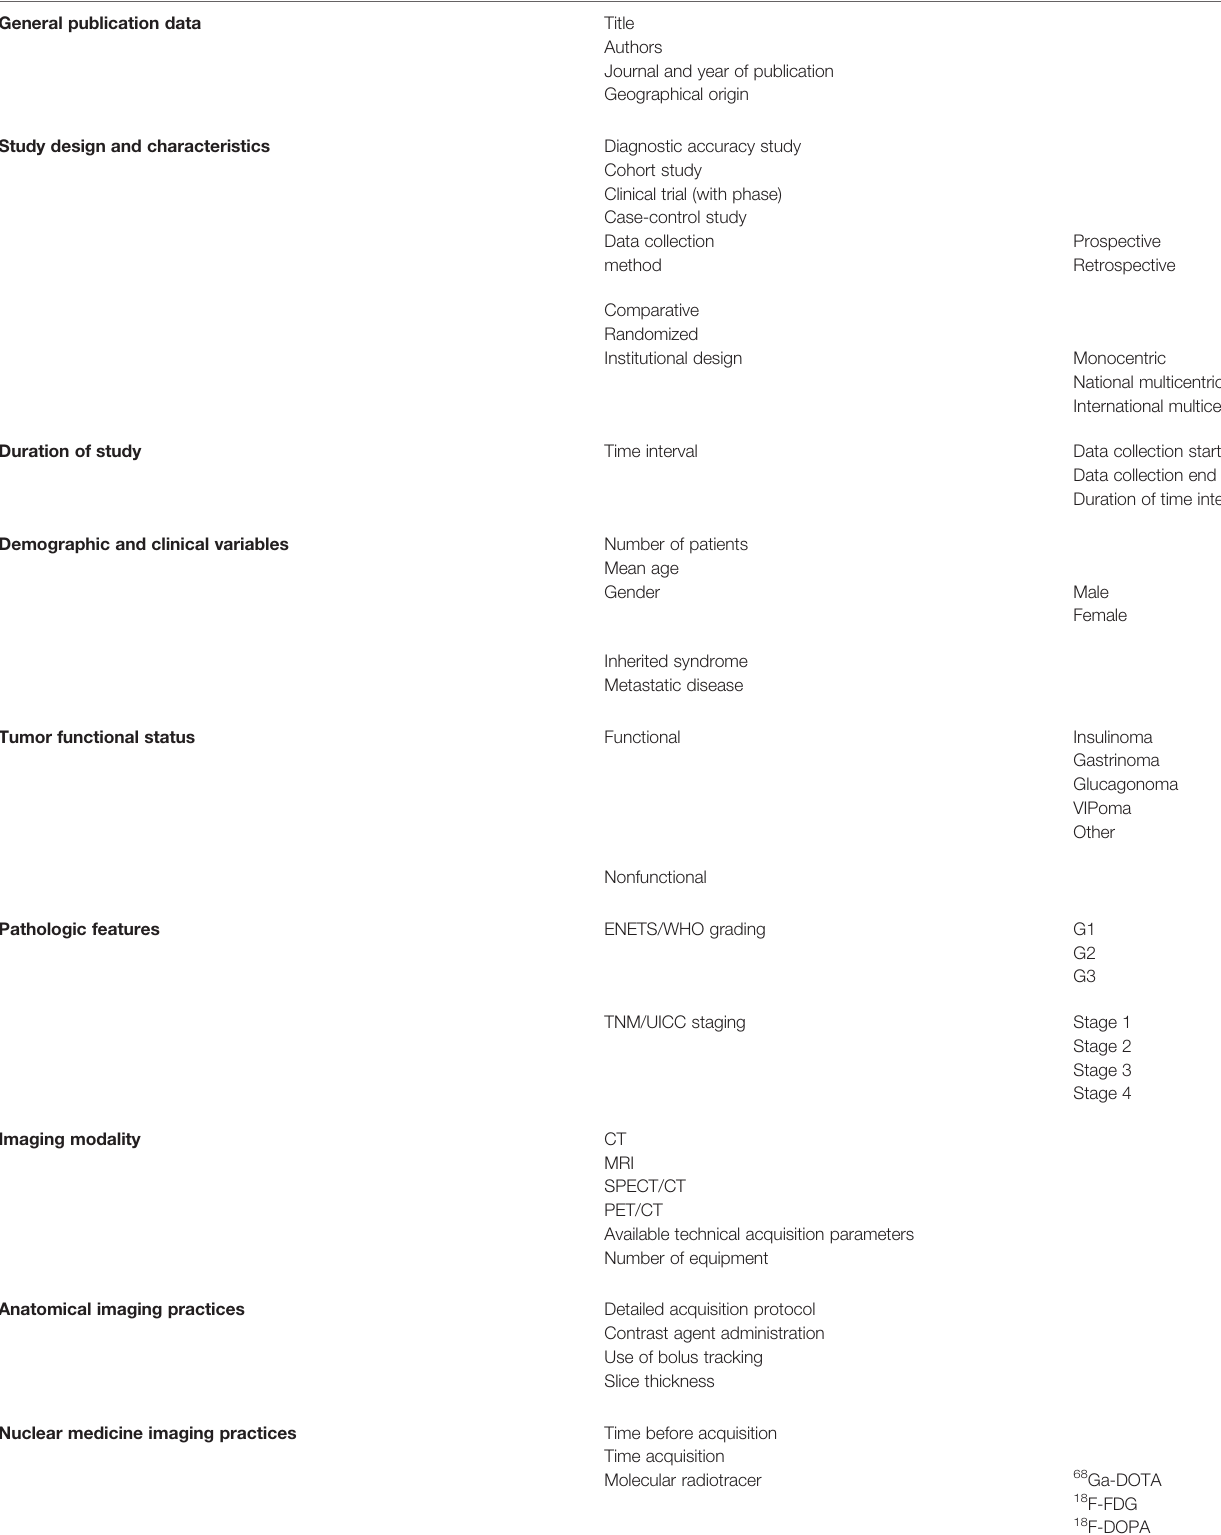
TABLE 1 | Extracted relevant